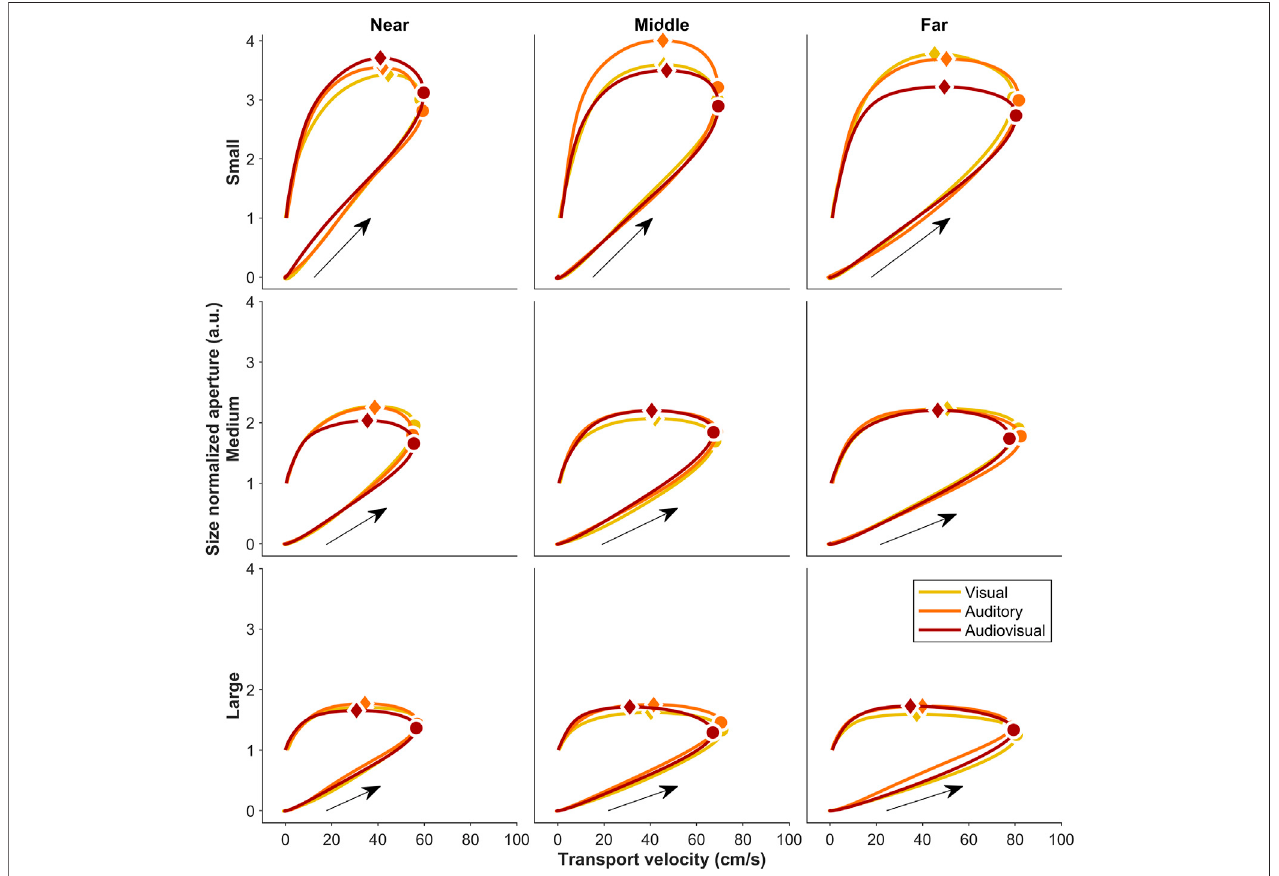
FIGURE 3 | Study 1. Phase plots of size-normalized aperture vs. transport velocity for each condition of sensory feedback for a representative participant. Diamonds and circles indicate size-normalized peak aperture and peak transport velocity, respectively. Black arrows indicate the progression of reach-to-grasp